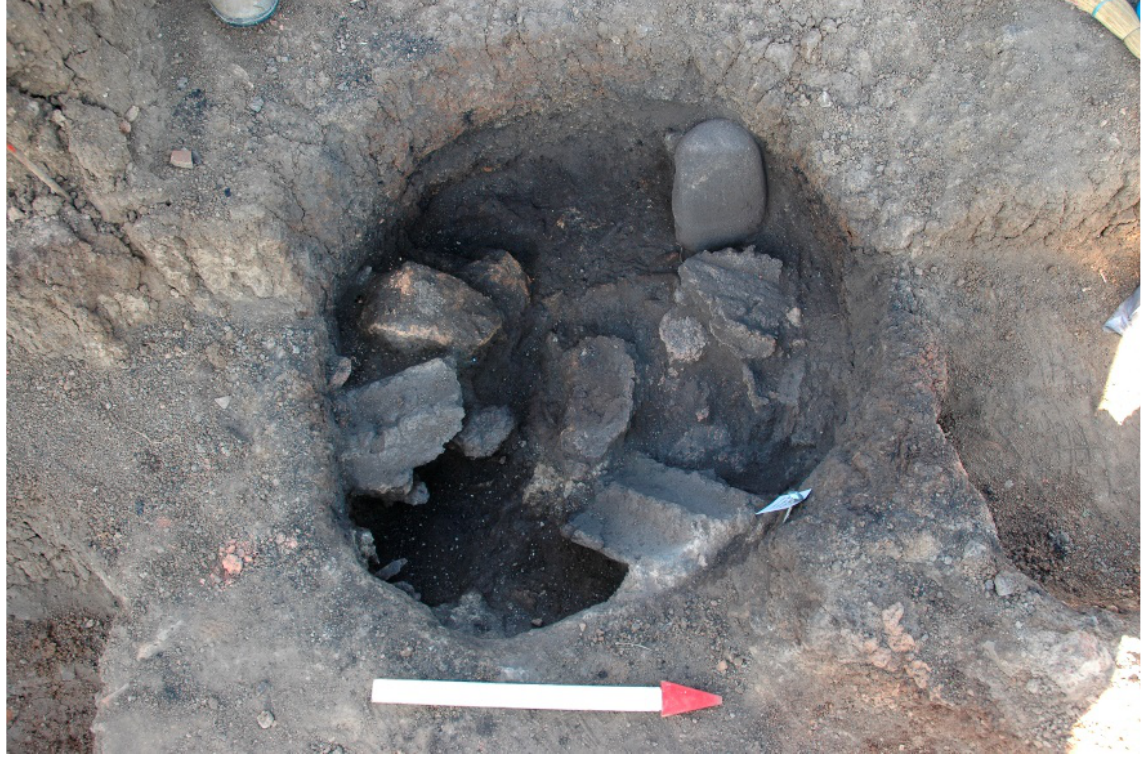
Figure 16. Grinding slab and daub fragment from Pit 282302 (AVGI